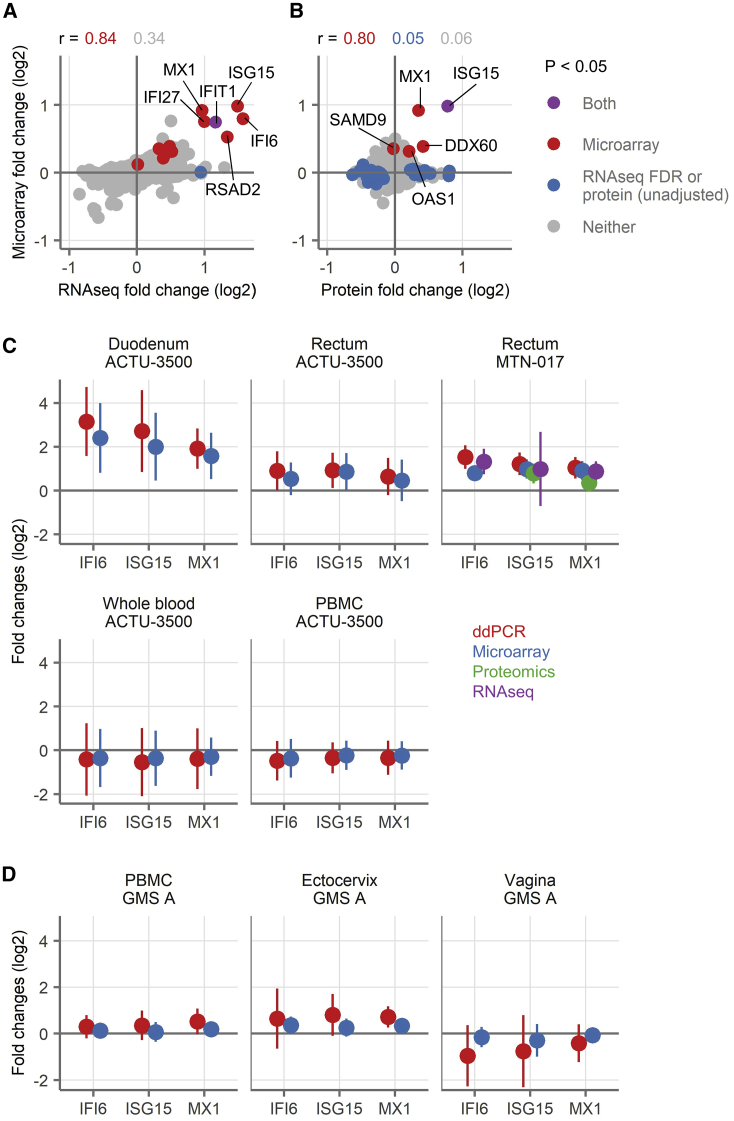
Comparison of Gene Expression Changes Measured by ddPCR, RNA-Seq, Proteomics, and Microarray(A and B) Correlation of fold changes of genes as detected by microarray (y axis) with genes detected by RNA-seq (A) or proteins detected by proteomics (B) from the rectal samples from MTN-017. The colors indicate genes with FDR-adjusted p < 0.05 in microarray transcripts (red), RNA-seq genes (blue, by FDR, A) or proteins (blue, unadjusted p value, B), both (purple, FDR for microarray and RNA-seq, unadjusted p value for protein), or neither (gray). Spearman correlation coefficients for the genes falling into each subset are shown. Selected genes are labeled.(C and D) Fold changes in gene expression of three genes (IFI6, ISG15, or MX1) as detected by ddPCR (red), microarray (blue), proteomics (green), and RNA-seq (purple) after treatment with TDF/FTC (C) or TDF alone (D). The symbols show the mean across all of the participants and vertical lines show the 95% confidence intervals of the mean.ISG15, ISG15 ubiquitin-like modifier; MX1, MX dynamin-like GTPase 1. A positive fold change means higher expression during treatment, and a negative fold change means higher expression off treatment. For ddPCR, the expression of each gene of these three genes was normalized to the expression of ubiquitin C (UBC), which was chosen as reference due to the stability of its expression across tissues and treatments in the microarray data. The sample sizes are shown in Table 1. Each sample was run in singlicate by RNA-seq, proteomics, and microarray, while samples were run in duplicate technical replicates by ddPCR.